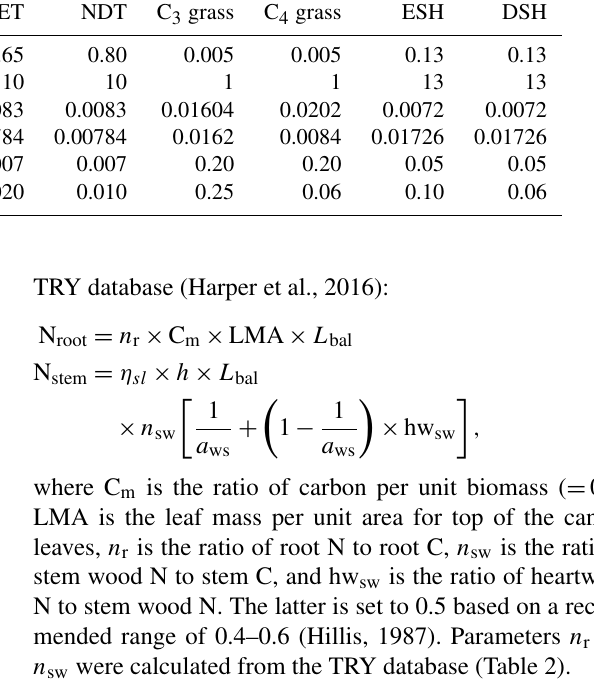
Table 2. Updated parameters for vegetation carbon, and root and stem nitrogen in JULES-C2. The parameters are as follows: a wl relates wood to leaf carbon (kgCm − 2 per unit LAI), a ws is the ratio of total wood carbon to respiring stem carbon, n r is the ratio of root nitrogen to root carbon, n sw is the ratio of stem wood nitrogen to stem carbon, and γ is the large-scale disturbance parameter (kgCm − 2 360d − 1 ) .